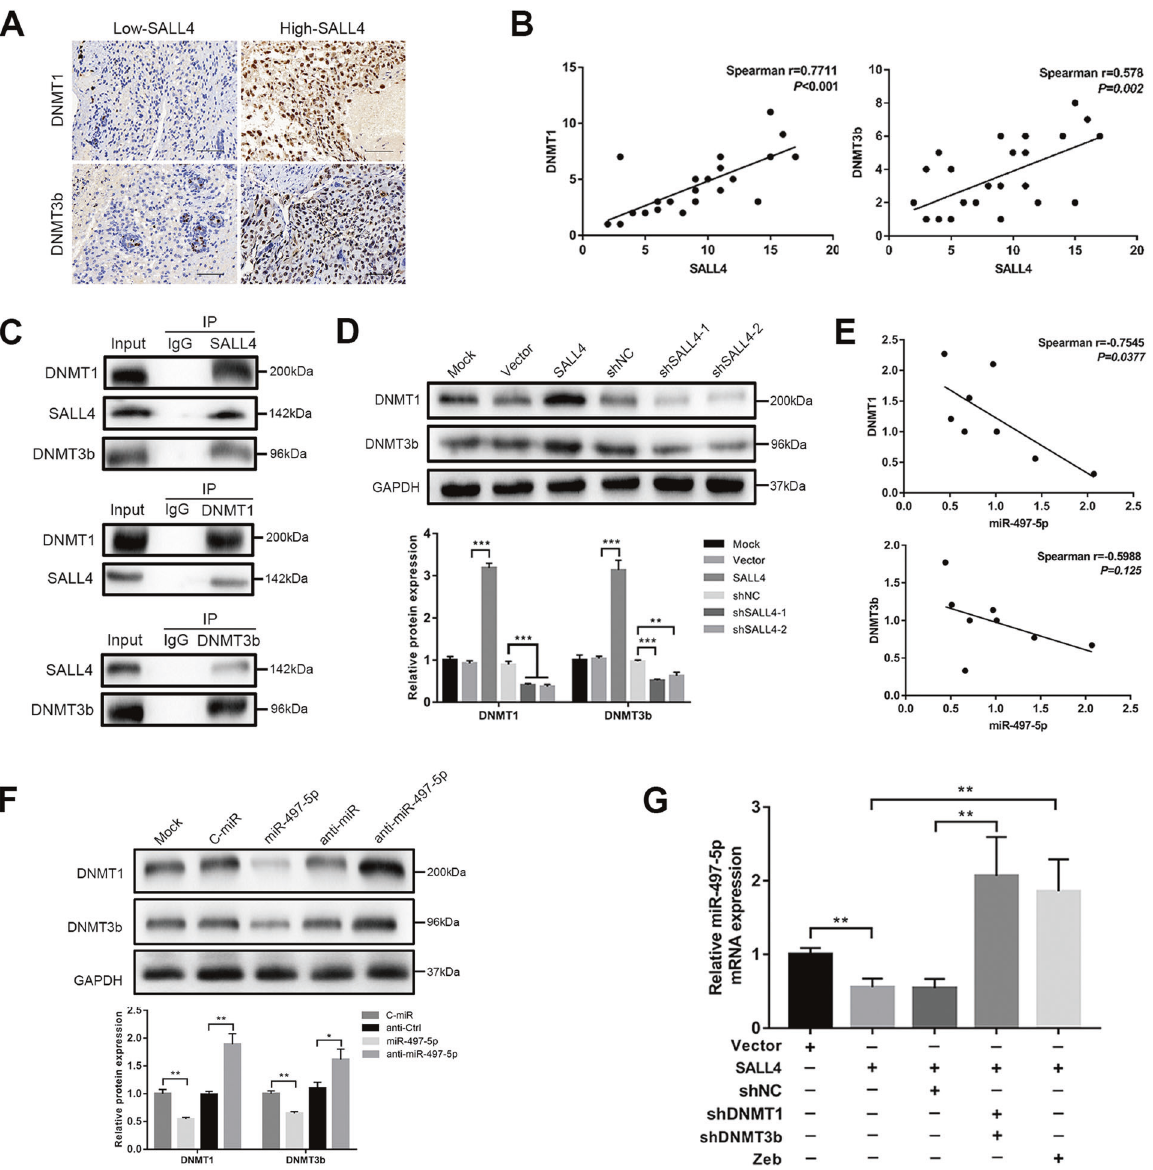
DNMT3b (right) based on IHC scores in 26 choriocarcinoma tissues. C Interactions between SALL4 and DNMT1 or DNMT3b in CSLCs. Co-IP assays showed endogenous SALL4 coprecipitated with DNMT1 and DNMT3b (top), and endogenous DNMT1 or DNMT3b coprecipitated with SALL4 (middle and bottom). D Respective images (top) and quanti fi cation (bottom) of DNMT1 and DNMT3b expression in CSLCs with SALL4 overexpression or silencing by western blotting. E Spearman correlation analysis for miR-497-5p and DNMT1 (top) or DNMT3b (bottom)